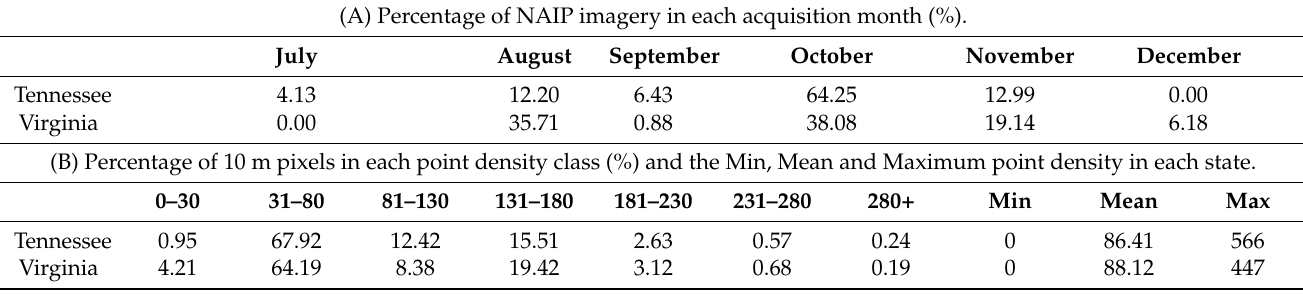
Table 2. NAIP point density by acquisition